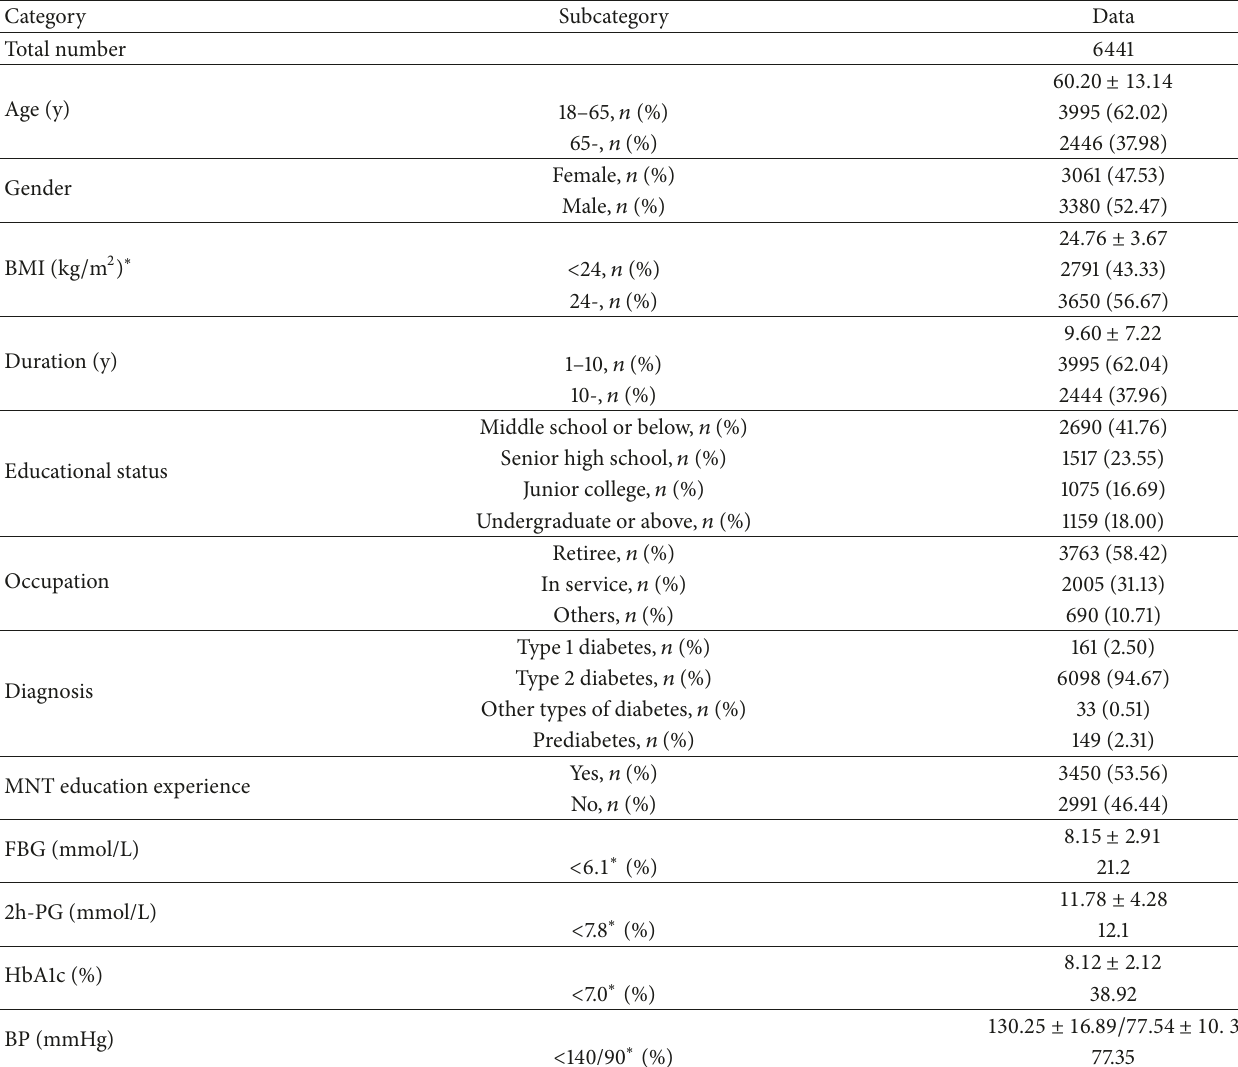
Table 1: General characteristics of the patients.